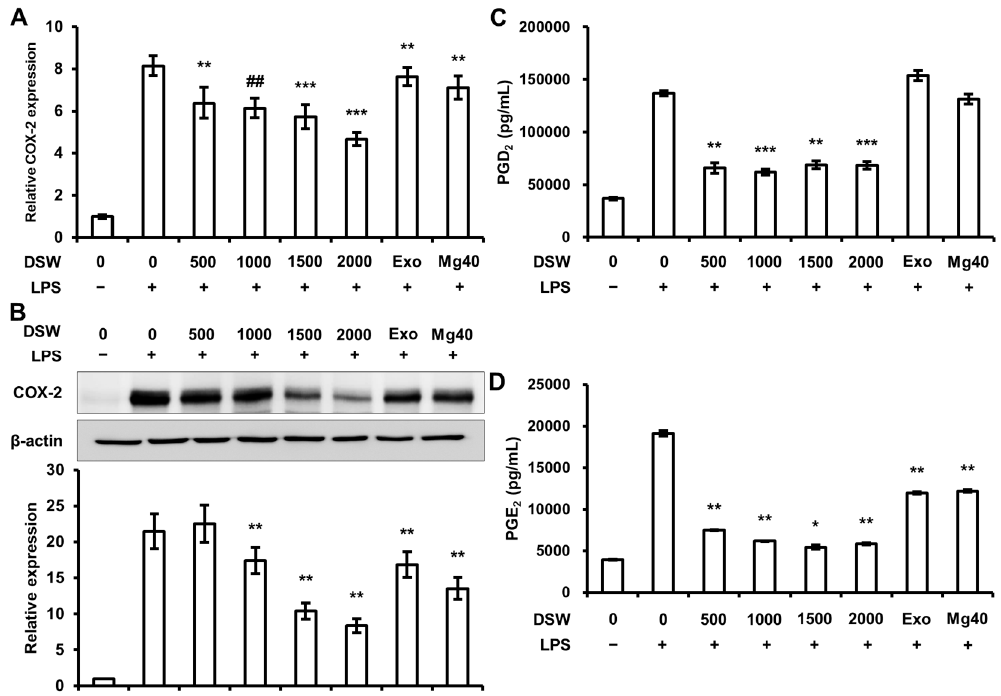
Figure 3. Effect of RDSW on LPS-induced COX-2 expressions and PGD 2 and PGE 2 secretions. Effects of RDSW on LPS-induced ( A ) mRNA and ( B ) protein expressions of COX-2 in RAW 264.7 macrophage cells. ( A ) GAPDH was used as an internal control; ( B ) band density was normalized with β -actin. The secretions of ( C ) PGD 2 and ( D ) PGE 2 were measured in a conditioned medium pre-treated with RDSW for 24 h prior to the stimulation of 1 µg/mL LPS for 24 h. The amount of PGD 2 and PGE 2 secretion in the medium was measured by ELISA kits in accordance with the manufacturer’s instructions and was normalized with the amount of total protein in each sample. All experiments were performed in triplicates, and all data are shown as the mean ± SD. * p < 0.05, ** p < 0.01, *** p < 0.001 and ## p < 0.00001 compared to the LPS-induced control. Exo: hardness 1500 of exogenous Mg and Ca mixture, Mg:Ca = 3.5:1; Mg40: hardness 1500 of high Mg DSW, Mg:Ca = 40:1.